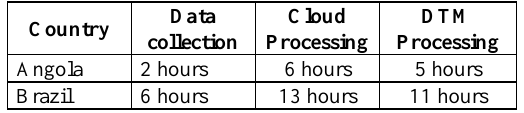
Table 2. Tasks processing